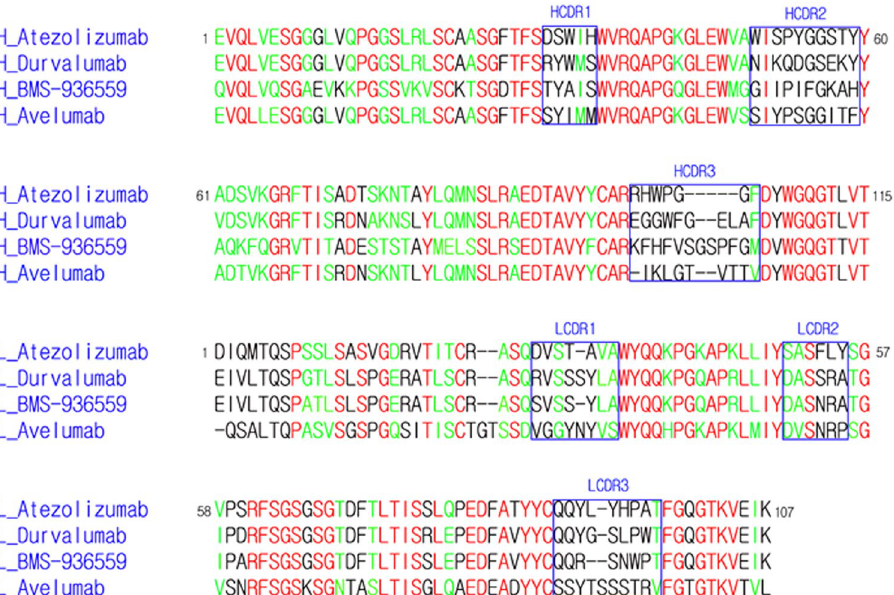
Figure 2. Sequence comparison of the antibodies against PD-L1. The CDRs are indicated with boxes and labeled. The residue numbers refer to those in atezolizumab. The identical and homologous residues are colored red and green,